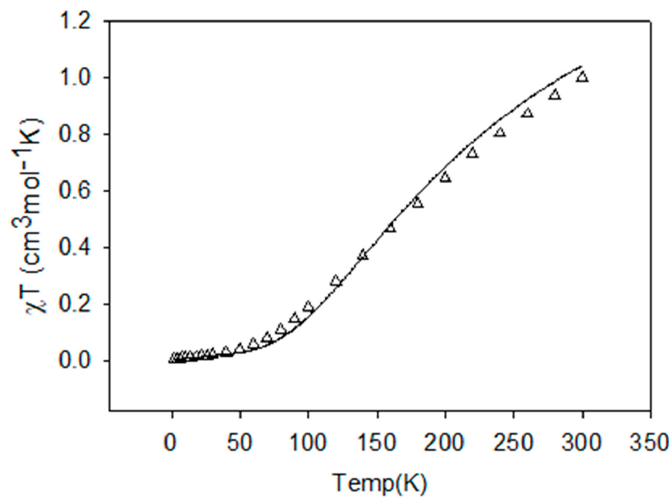
Figure 12. Plots of χ M T (triangles) vs. T per mole of [Cu 2 ] unit for 1 . The solid line is the best fit to the experimental data.